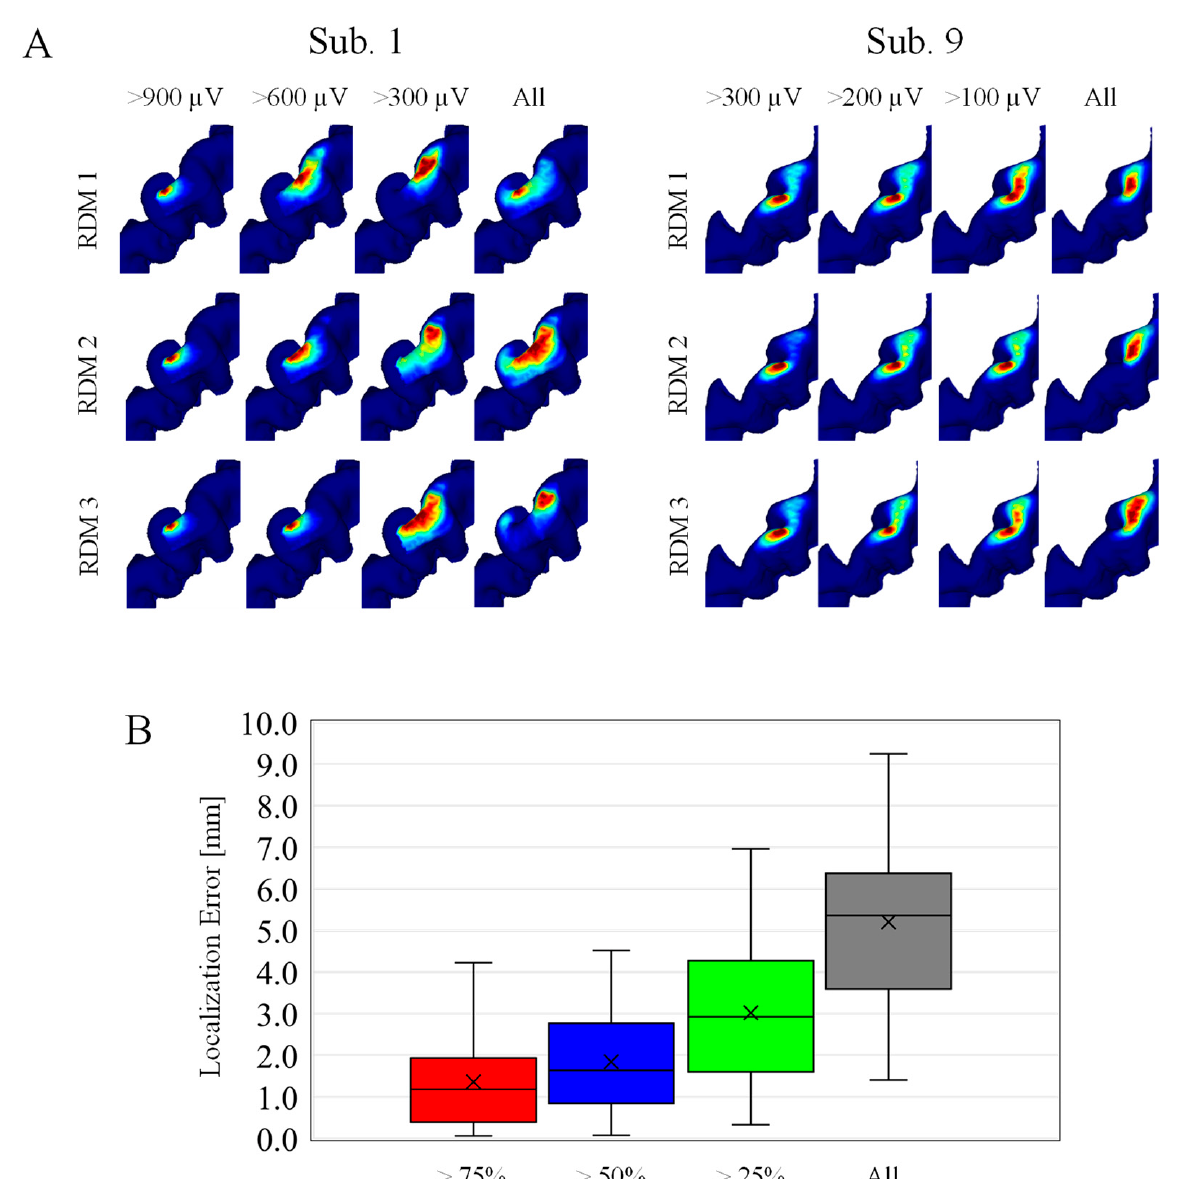
Figure 5. ( A ) Individualized localizations on randomly selected samples. The four columns corre- spond to different MEP amplitude categories. Each row corresponds to three representative cases within the 100 random (RDM) trials. ( Left ) Subjects with higher MEP response, and ( Right ) subjects with smaller MEP response at 55% MSO. ( B ) Localization errors across subjects in four different MEP amplitude categories ( n = 100).